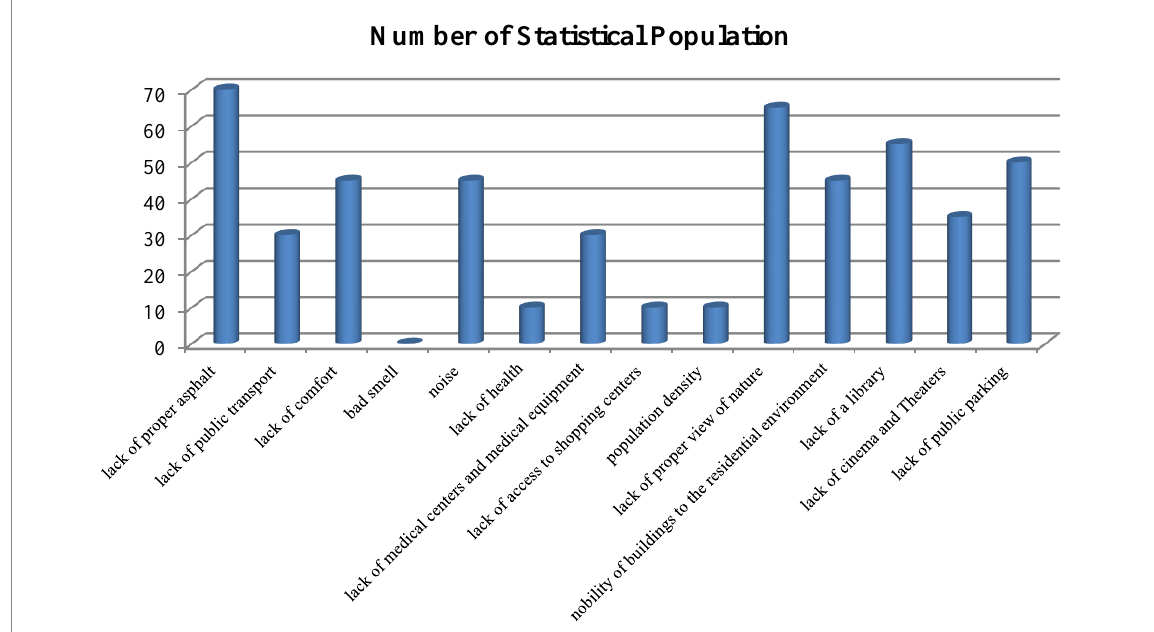
Figure 11. The most important problems of the neighbourhood from the view point of